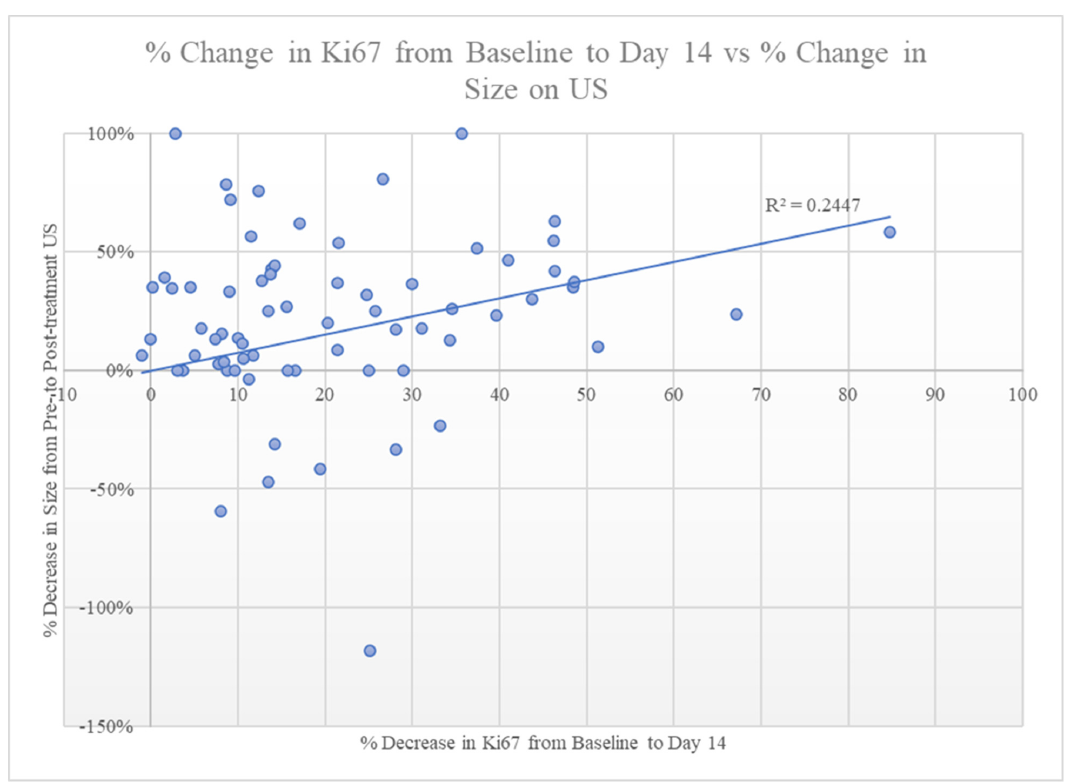
Figure 3. Comparison of the percentage decrease in the Ki–67 proliferation index from baseline to day 14 versus the percentage decrease in size seen on baseline US to EOT US, demonstrating no correlation between the two measurements.